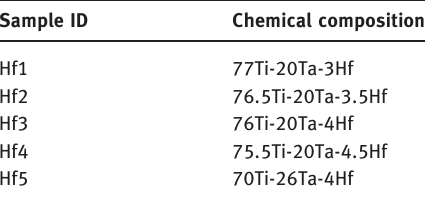
Table 1: Chemical composition (at%) and sample ID of the alloys produced.